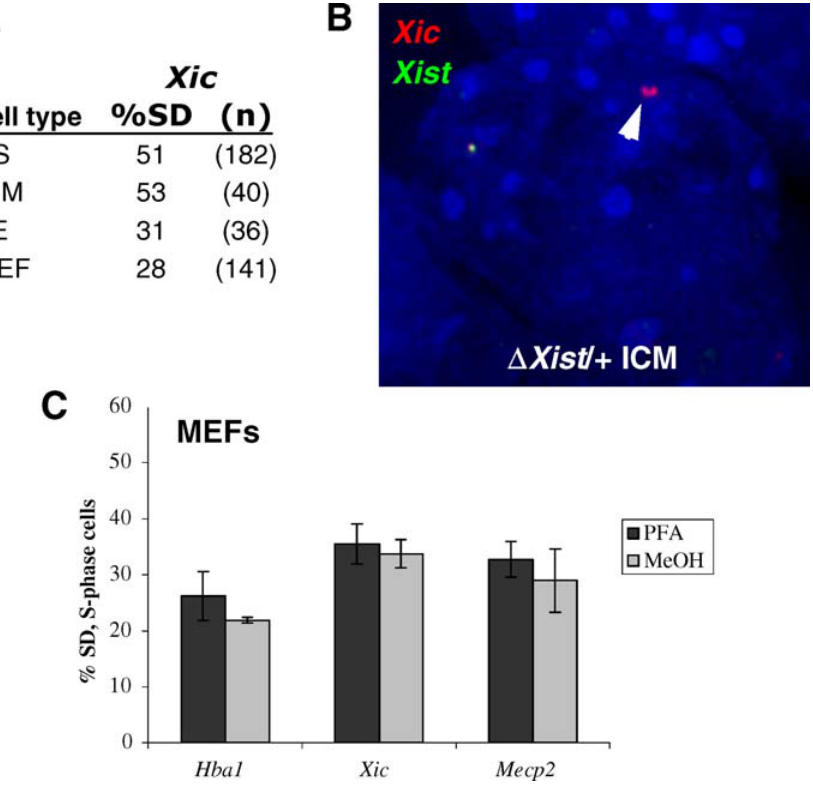
Figure 5. SIAR Is Specific to Pluripotent Cells In Vitro and In Vivo (A) Percent SD signals observed by FISH for the Xic in cell types that are poised for X-inactivation (ES and ICM), and in trophectoderm (TE) cells and MEFs, which have completed X-inactivation. (B) Allele-specific FISH for the Xic (red) in D Xist / þ ICM cells. An Xist probe (green) identifies the wild-type allele; white arrowhead indicates the D Xist allele. In 12 of 15 SD cells ( p ¼ 0.02), the D Xist allele exhibited the doublet signal. (C) Percent SD signals observed for an autosomal biallelic locus (Hba1) and two X chromosomal loci (Mecp2 and the Xic) in MEFs fixed with PFA (dark gray) or MeOH (light gray). Average data from two experiments ( n (cid:1) 150) are presented; error bars indicate one standard deviation. See Figure S4B for complete scoring of SS, SD, and DD signals. DOI: 10.1371/journal.pbio.0040159.g005 PLoS Biology |